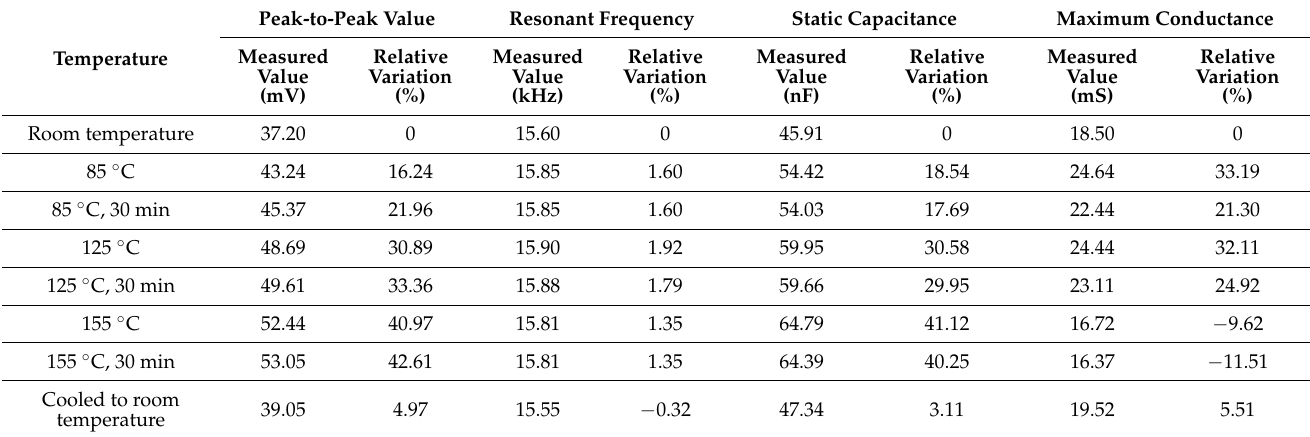
Table 1. Experimental test results of a piezoelectric vibrator at different temperatures.